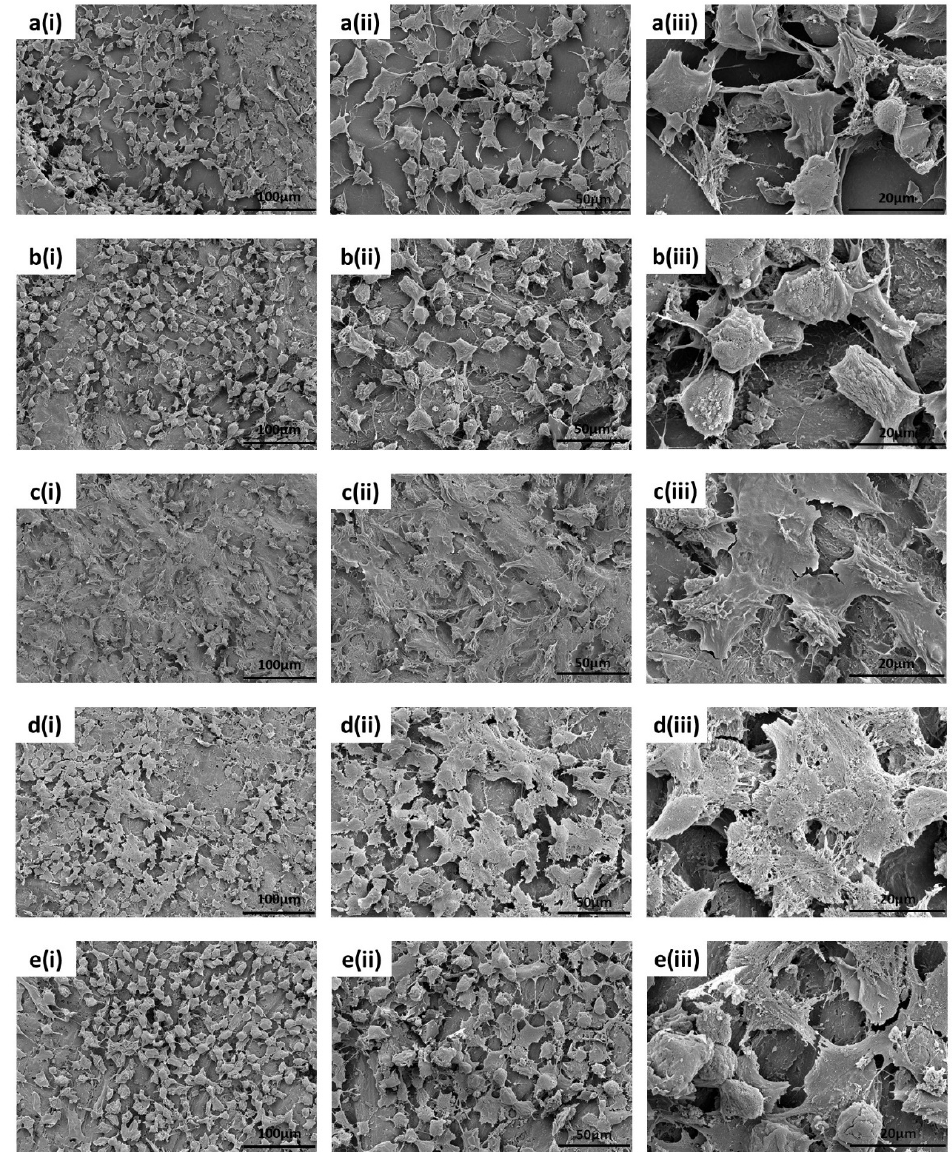
Figure 14. SEM results showing the morphology of U-2 OS cells adhered to the 3D printed samples and cultured under standard conditions for 7 days at magnifications of ( i ) × 300, ( ii ) × 600 and ( iii ) × 2k. Samples ( a ) i – iii (0HA), ( b ) i – iii (5HA), ( c ) i – iii (10HA), ( d ) i – iii (20HA), and ( e ) i – iii